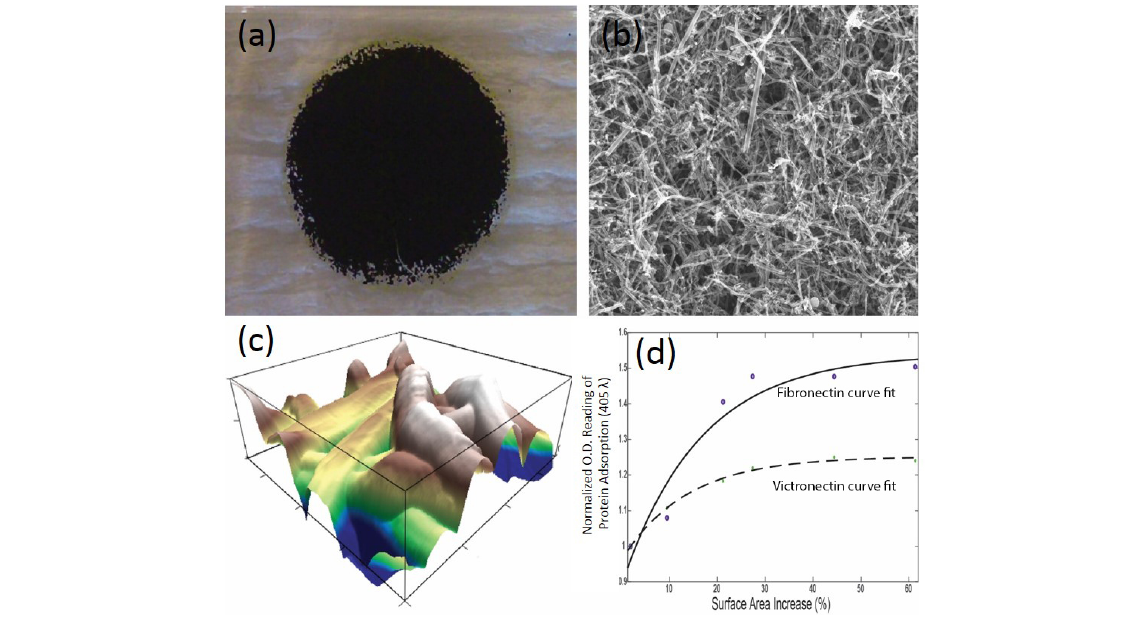
Figure 4. Cardiovascular patches embedded with nanomaterials play a key role in promoting stem cell growth around an infarct area of the myocardium: ( a ) the use of poly(lactic-co-glycolic) acid (PLGA) embedded with carbon nanofibers (CNFs) to generate a carbon nanofiber reinforced patch; ( b ) scanning electron micrograph of carbon nanofiber reinforced patch showing CNFs embedded in PLGA (at 10 K magnification); ( c ) atomic force micrograph of a carbon nanofiber reinforced patch depicting the topography of the patch; ( d ) using the data from atomic force micrographs to calculate the increase in surface area as one increases CNF concentration vs. protein adsorption, one can see that using CNFs can increase protein adsorption of a carbon nanofiber reinforced patch, thus increasing the possibility of cell recruitment and